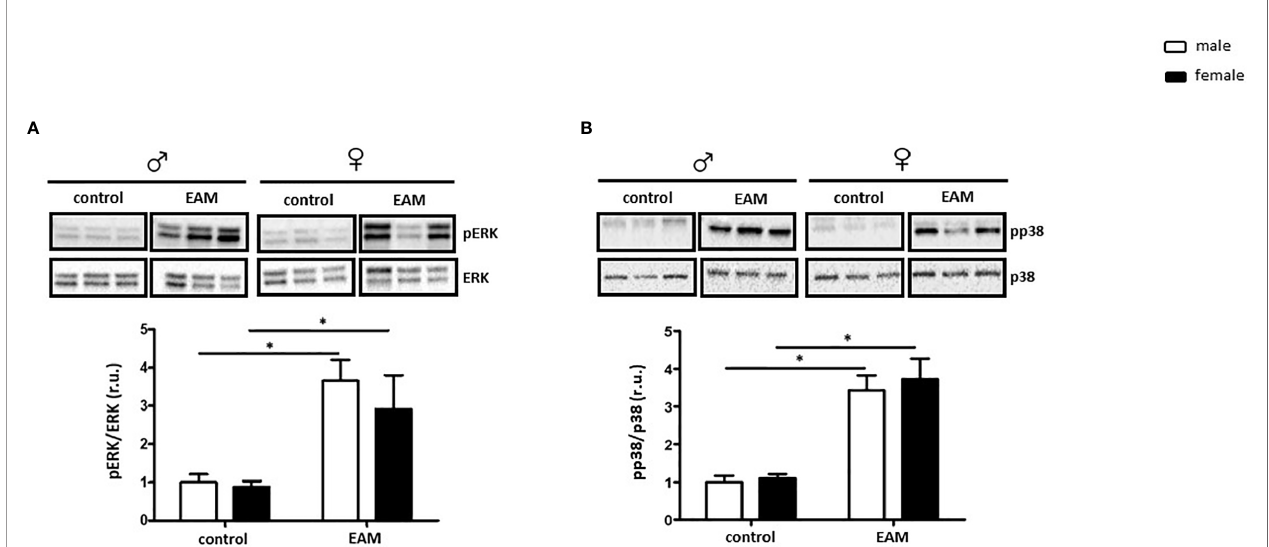
FIGURE 4 | Sex-independent ERK and p38 activation in the EAM model. Western blot analysis of pERK/ERK ratio (A) and pp38/p38 ratio (B) in cardiac tissue lysates from control or EAM, male ( ♂ ) and female ( ♀ ). Data are shown as the mean ± SEM (n= 5-12). *p < 0.05. Representative imaging of western blot analysis; the lanes were run in the same gel. All data were normalized to the corresponding control and expressed in relative units (r.u.).